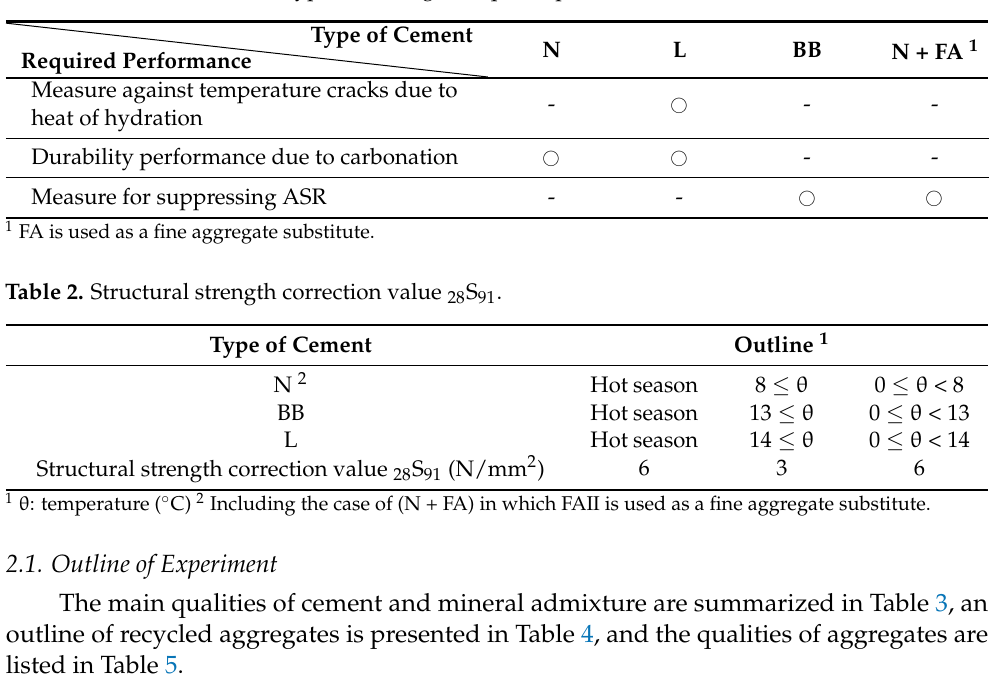
Table 1. Selection of cement type according to required performance [2].